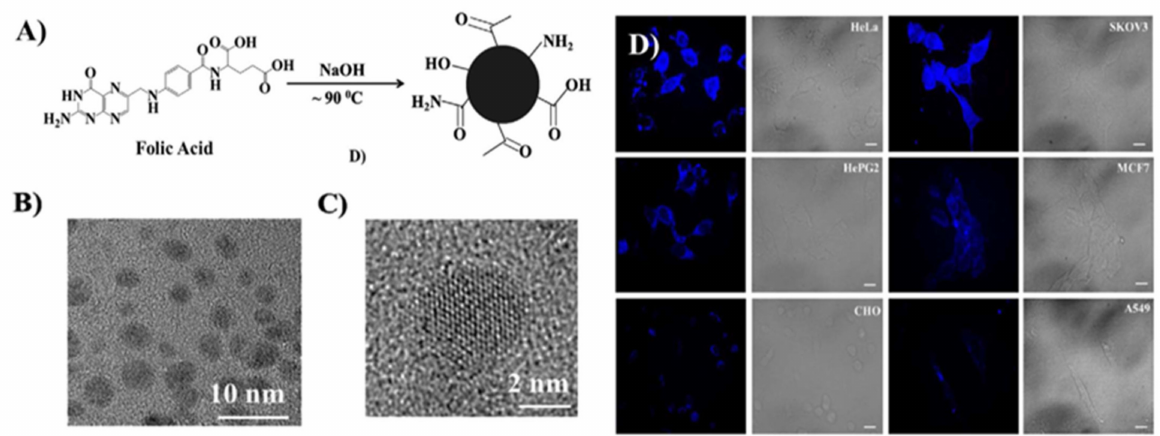
Figure 5. ( A ) Synthesis of the CDs from folic acid. ( B ) Transmission electron microscopy (TEM) imag- ing of the CDs. ( C ) High-resolution TEM (HR-TEM) image of a CDs. ( D ) CDs used for fluorescence microscopic imaging of cells expressing the folate receptor to different degrees [83], scale bars are 10 µ